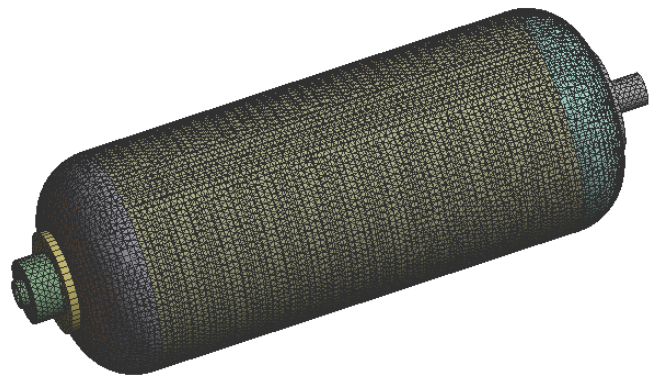
Figure 4. Finite element model of the CNG fuel tank with 91,622 elements [5].